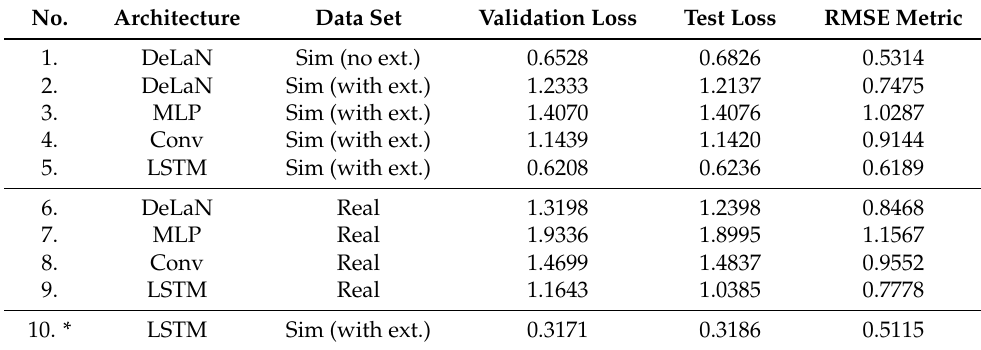
Table 3. Joint torque estimation summary.